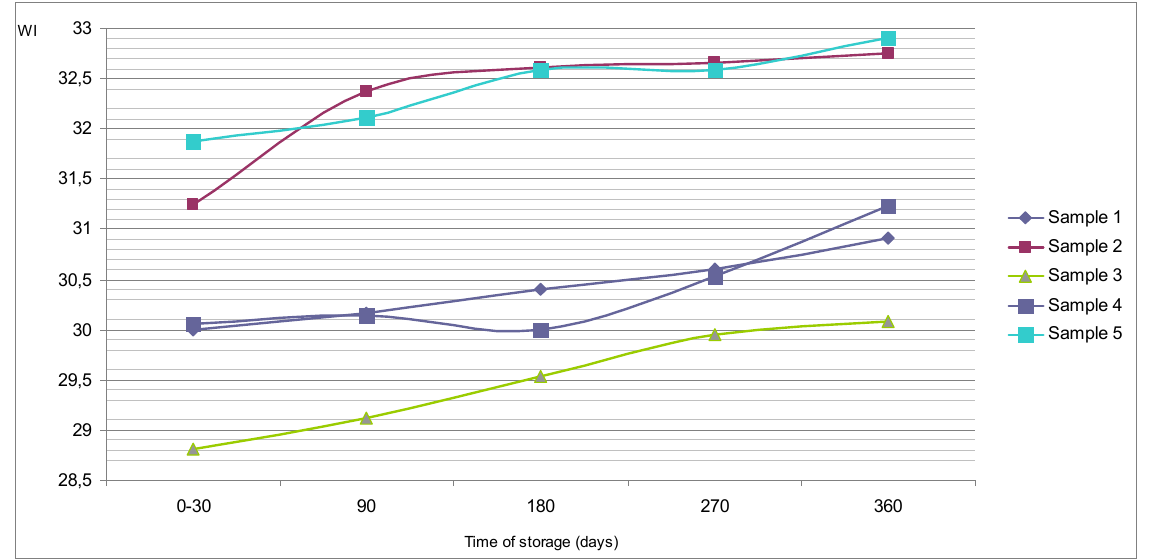
Figure 6 . Changes of whiteness index (WI) on the top surface of samples of dietary chocolates during storage of 360 days.